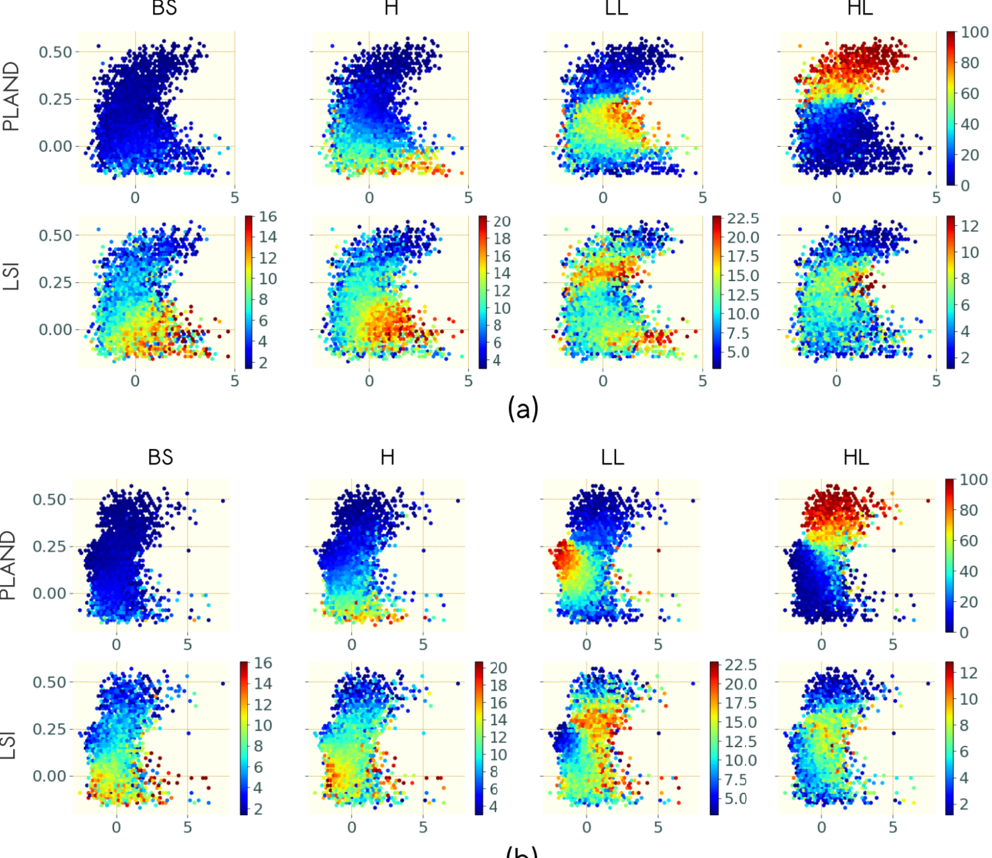
Figure A3. PLAND and LSI distribution for bare soil (BS), herbs (H), low ligneous (LL), high ligneous (HL), on the 2D plane defined by ( a ) the VFTG and mean NDVI and ( b ) the TG-2 and the mean NDVI computed on airborne